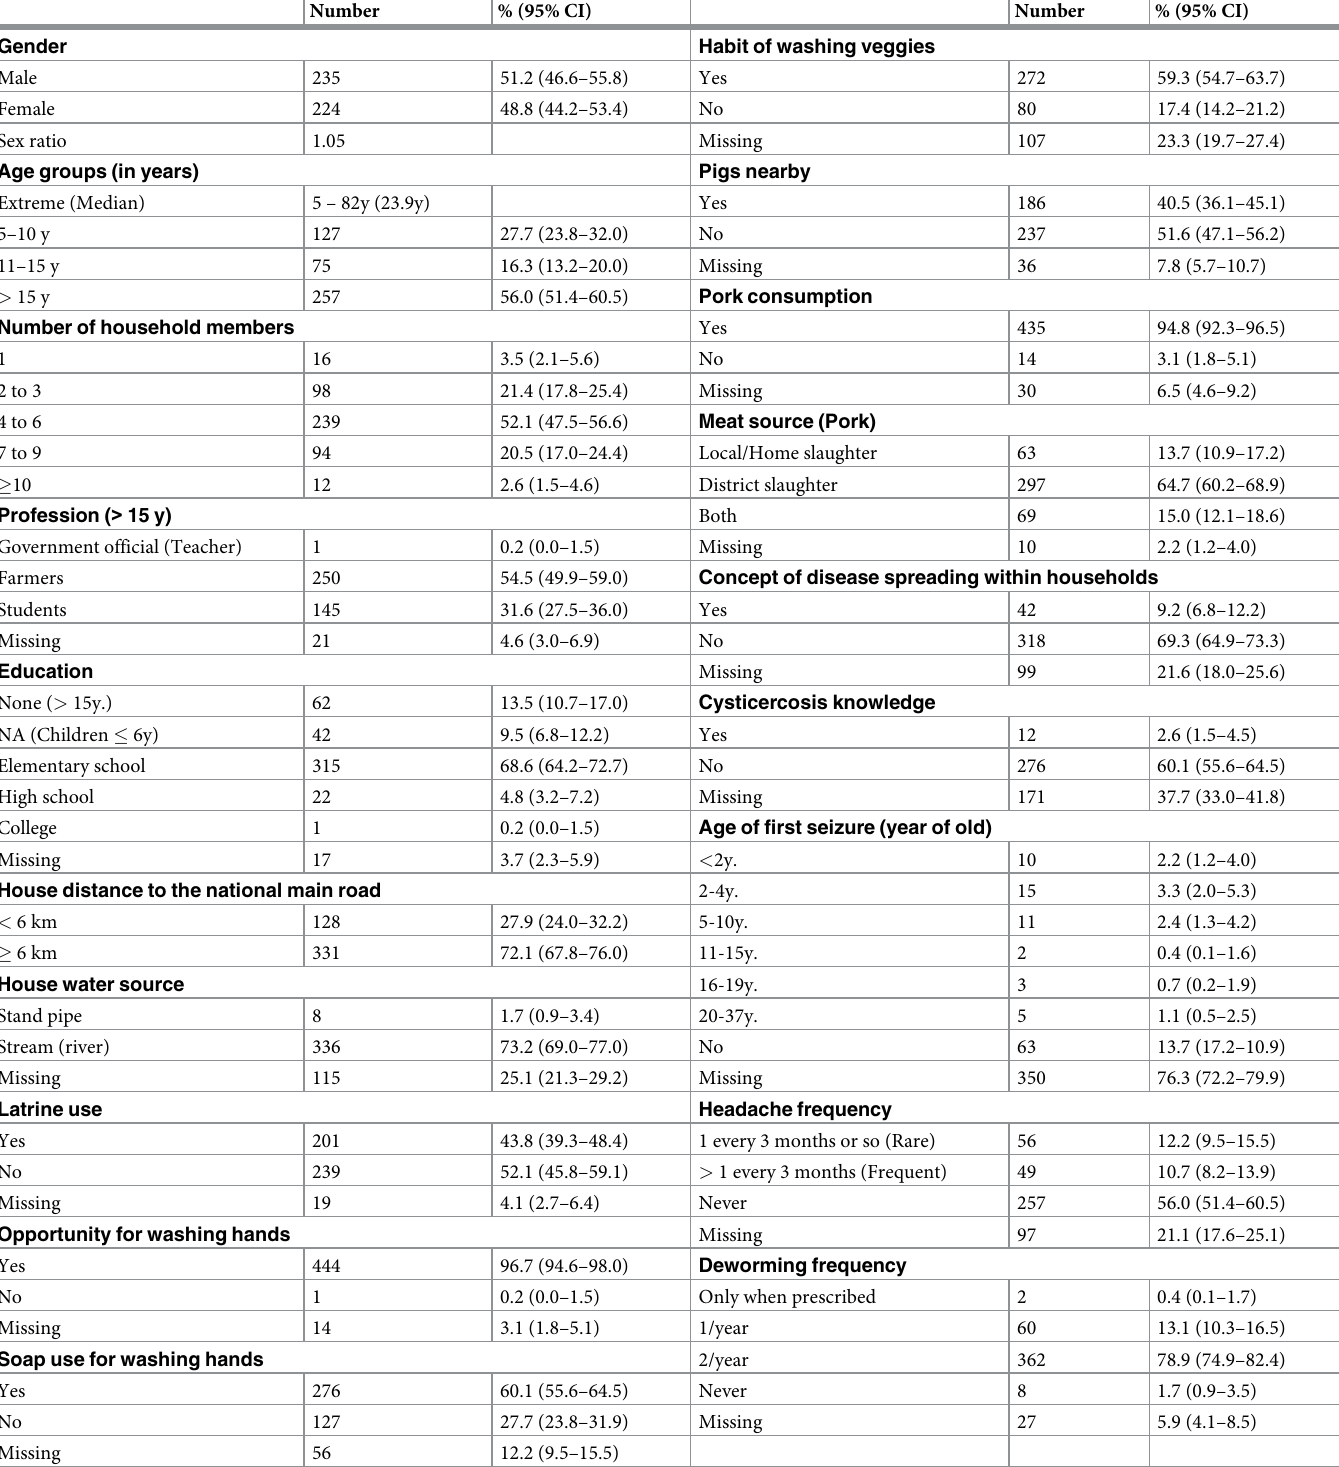
Table 1. Characteristics, behaviours, health and hygiene conditions of the study population (n =